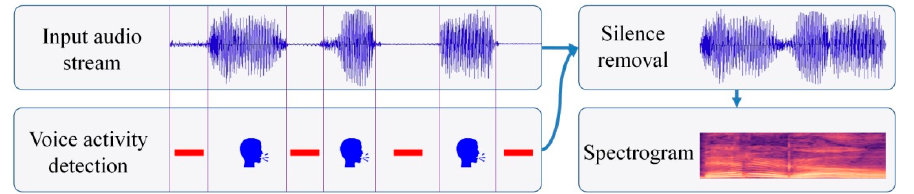
Figure 2. Audio signal pre ‐ processing: voice activity detection, silence removal and spectrogram image computation.